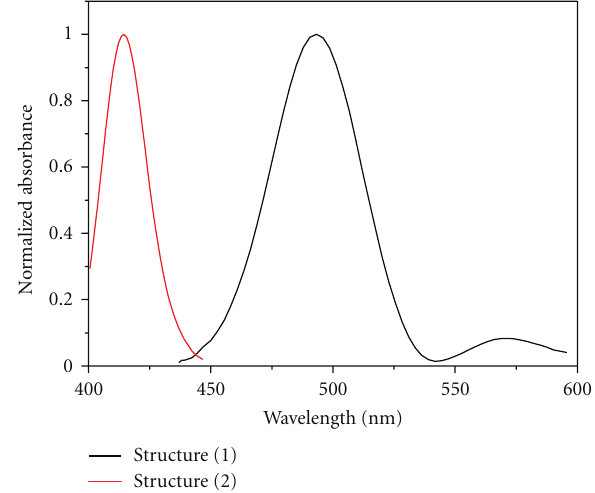
Figure 6: Calculated UV-VIS spectra of the possible reaction products of the chromotropic acid-formaldehyde reaction. Struc- ture (1): monocationic dibenzoxanthylium structure; structure (2): para , para -quinoidal structure (for structural formulae see Figure